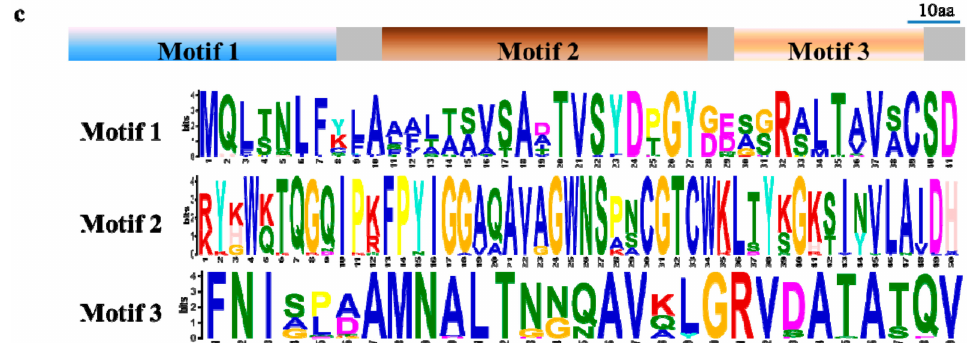
Figure 1. Bioinformatics analysis of the cerato-platanin-like FocCP1 protein. ( a ) The phylogenetic relationship of FocCP1 and other CPPs was determined using the maximum-likelihood algorithm. Branch lengths are proportional to the average probability of change for characters on branch. The arrow represents FocCP1 protein. ( b ) The predicted 3D structures of FocCP1 compared with Foc1CP (N4TJM2) and FolCP (A0A0D2YA76); there is high similarity in the 3D structures of CPPs. ( c ) Conserved motifs of CPPs were predicted using the MEME suite. CPPs exhibit three motifs, and each motif possesses some conserved amino acid. In total, 48 CPPs were used for analysis.